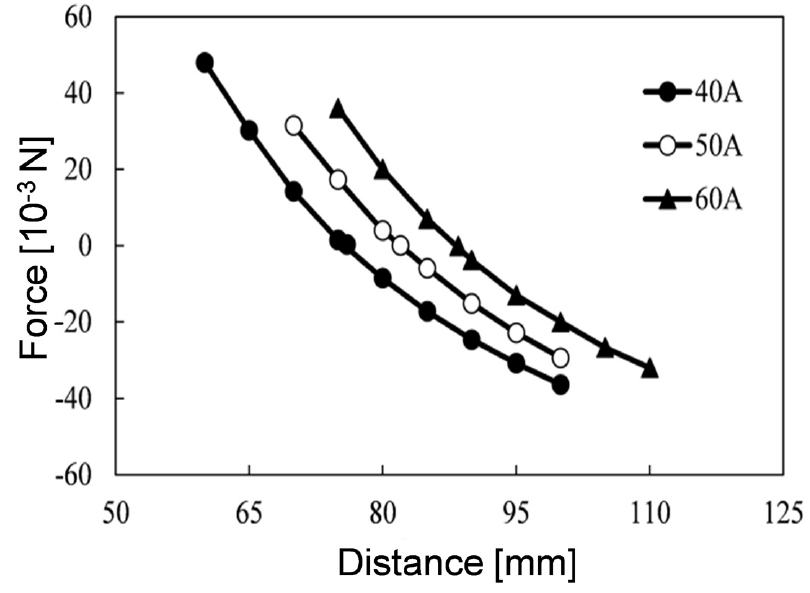
Figure 6. Relationship between suspension force and distance from a superconducting coil to the suspended object.